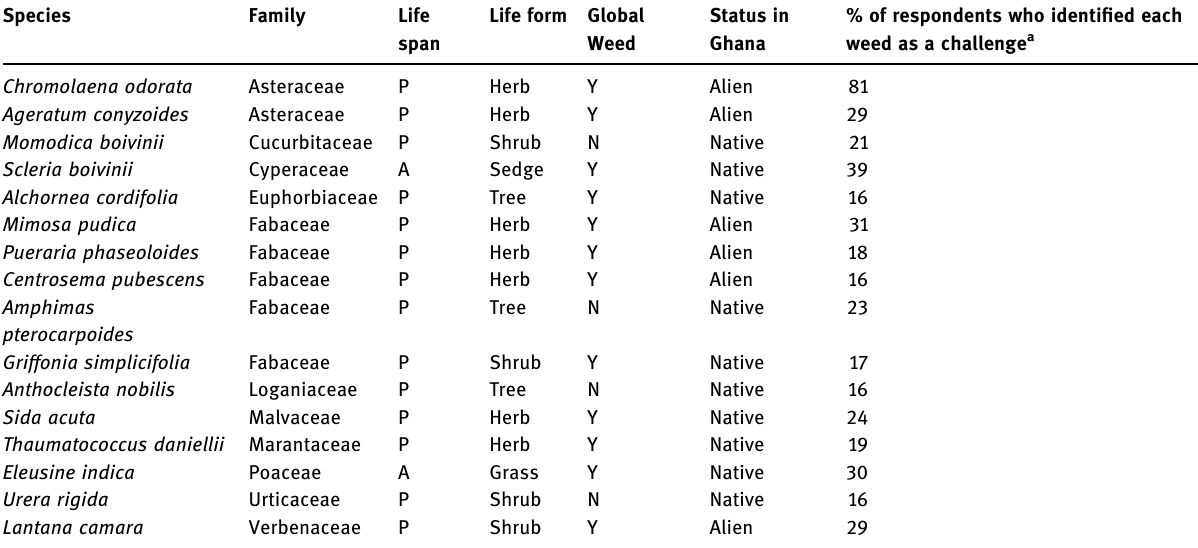
Table 3: Common weed species troubling smallholder farmers in Western Ghana